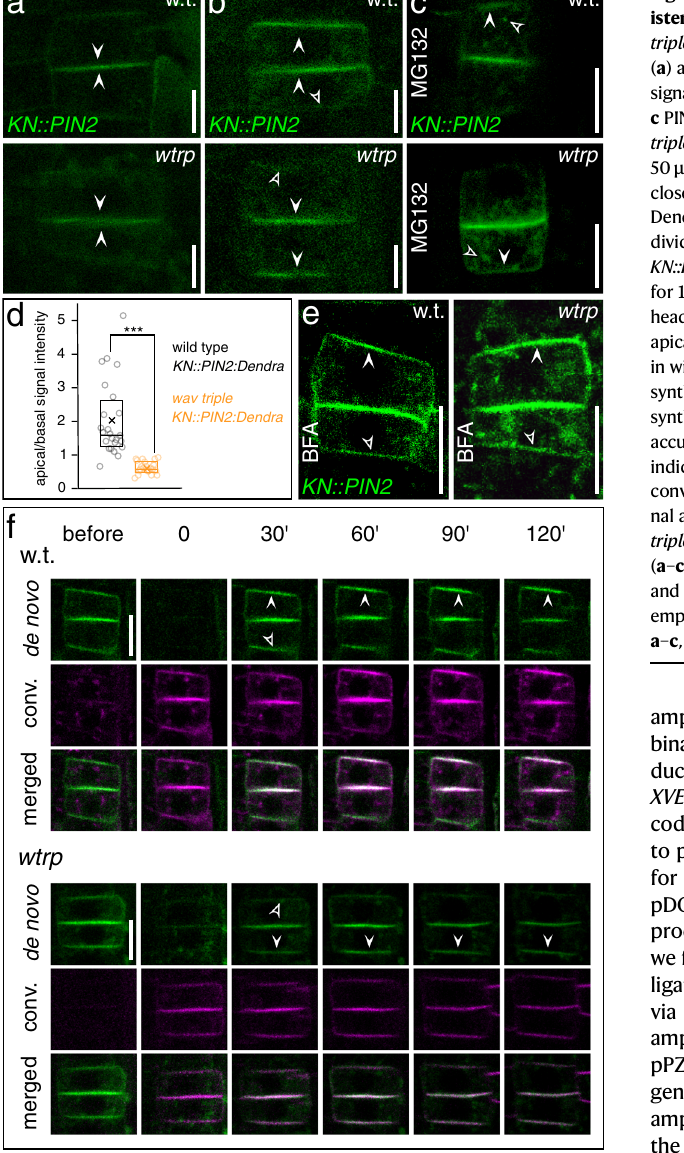
Fig. 8 | WAV3/WAVH function in polar PIN2 sorting in cytokinetic root mer- istemcells. PIN2:Dendrasignalsindividingcellsof5DAG KN::PIN2:Dendra and wav tripleKN::PIN2:Dendra .Arrowheadsindicatereporteraccumulationatthecellplate ( a ) and at apical and basal domains, respectively ( b ). Open arrowheads: limited signal accumulation at the wild type basal domain and wav triple apical domain. c PIN2-Dendra signals in dividing wild type (w.t.) KN::PIN2:Dendra (top) and wav tripleKN::PIN2:Dendra (bottom)rootmeristemepidermiscells,aftertreatmentwith 50 μ M MG132 for 2h. Open arrowheads indicate intracellular signal accumulation, closed arrowheads indicate polar localization at the PM. d Quanti fi cation of PIN2- Dendra polarity in wild type ( n =24/14 roots) and wav triple ( n =22/19 roots) dividing root meristem cells at 5 DAG; n =22 – 24. e PIN2:Dendra signals in KN::PIN2:Dendra and wav triple KN::PIN2:Dendra , after treatment with 10 μ M BFA for 16h. Arrowheads indicate apical localization of reporter signals. Open arrow- heads: limited signal accumulation at the wild type basal domain and wav triple apicaldomain. f KN::PIN2:Dendra photoconvertedbefore polarity re-establishment in wild type (w.t.; top) and wav triple ( wtrp ; bottom), to follow the fate of de novo synthesized PIN2 for 120min. Arrowheads indicate polar localization of de novo synthesized PIN2 at apical and basal PM domains. Open arrowheads: limitedsignal accumulationatthewildtypebasaldomainand wavtriple apicaldomain. ‘ denovo ’ indicates protein accumulating after conversion (green); ‘ conv. ’ represents the converted protein fraction (magenta). Open arrowheads point towards minor sig- nal accumulation at the basal domain in wild type and the apical domain in wav triple cytokineticcells( b , e , f ).Threeindependentexperimentswereperformedfor ( a – c ) and ( e , f )with similarresults. Circles represent singledatapoints;boxes: fi rst and third quartiles; center line: median; ‘ x ’ : mean value. Two-tailed t-test was employed to determine statistical signi fi cance ( d ); ***: p <0.001. Scale bars: a – c , e =10 μ m; f =5 μ m. Source data are provided as Source Data fi